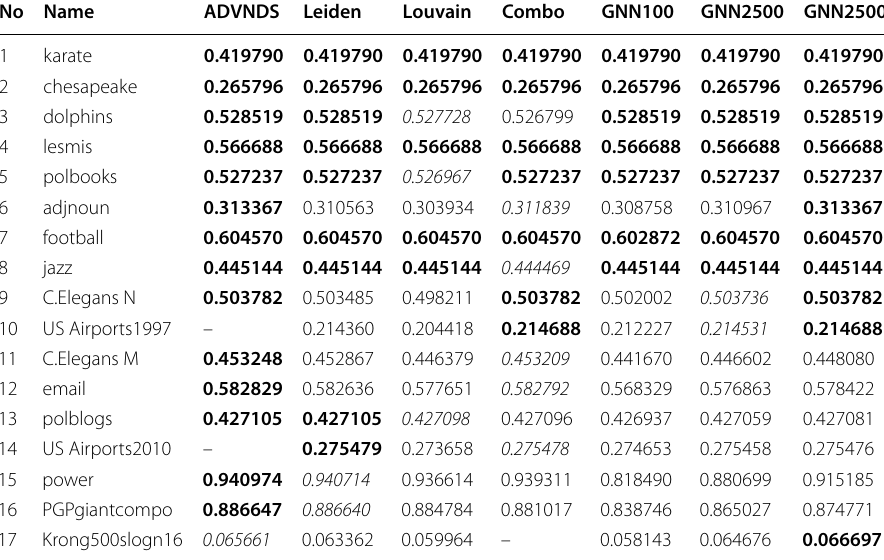
Table 4 Best modularity scores of the ADVNDS, Leiden, Louvain, Combo, and GNNS algorithms over the classic network